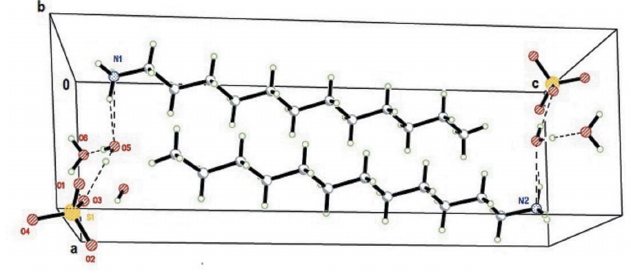
Figure 2 The expanded asymmetric unit with displacement ellipsoids drawn at the 30% probability level. Hydrogen bonds are shown as dashed lines.